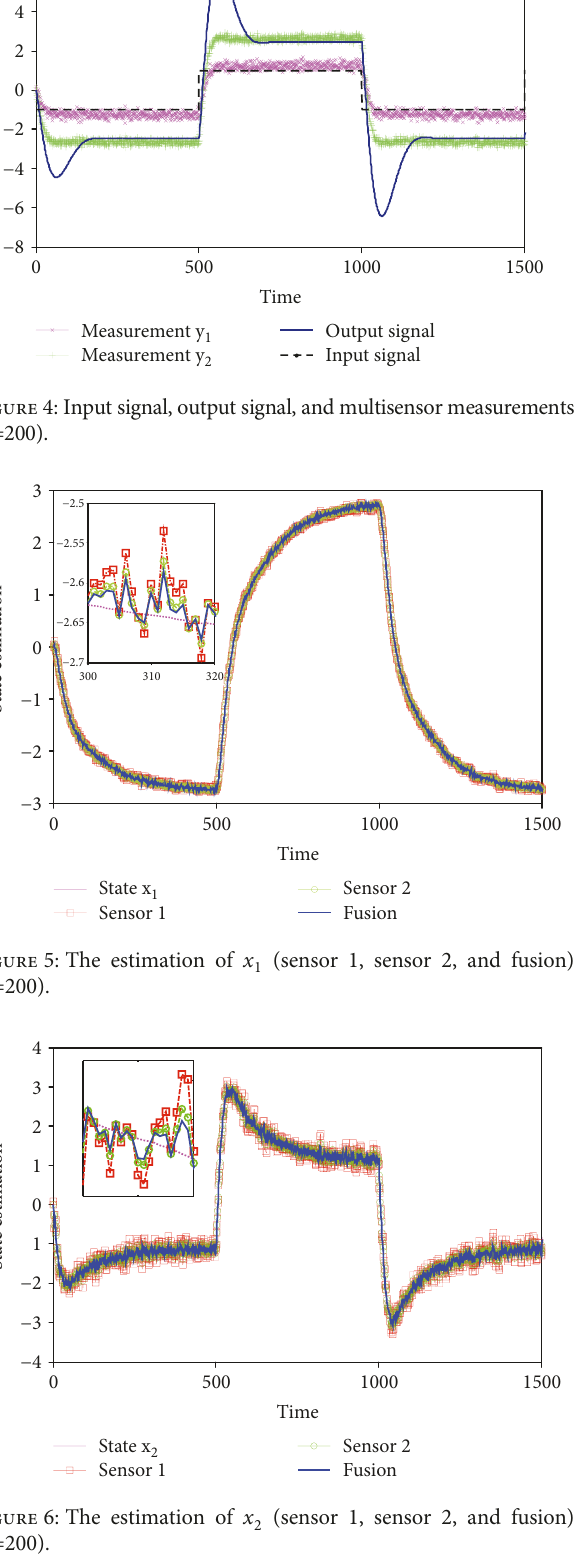
2 (sensor 1, sensor 2, and fusion)